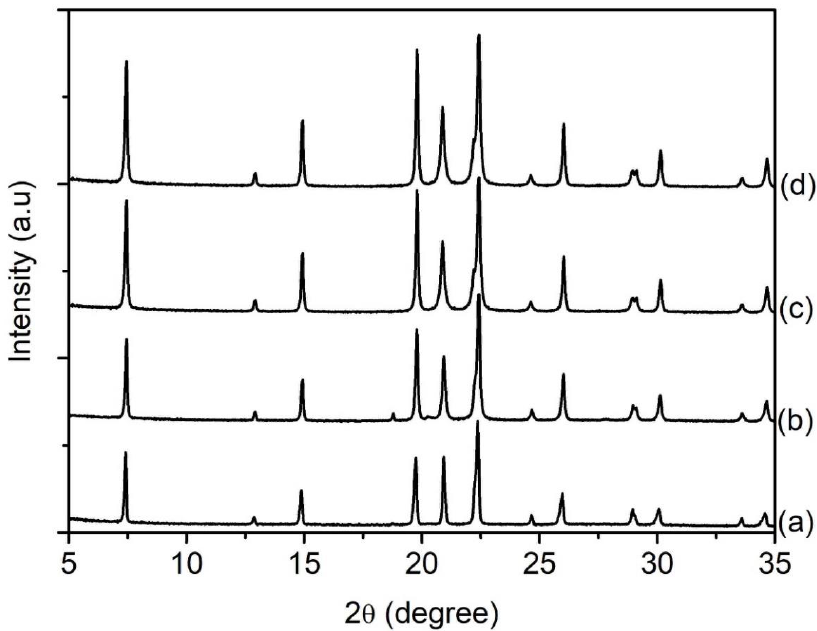
Figure 5. XRD patterns of ( a ) SH9 ( x = 1.5), ( b ) SH10 ( x = 2.0), ( c ) SH4 ( x = 2.5) and ( d ) SH11 ( x = 3.0) where the solid products were prepared using precursor hydrogels with a molar composition of1Al 2 O 3 : x P 2 O 5 : x [bzmIm] 2 O:180H 2 O:0.47SiO 2 at 150 °C for 10 h.